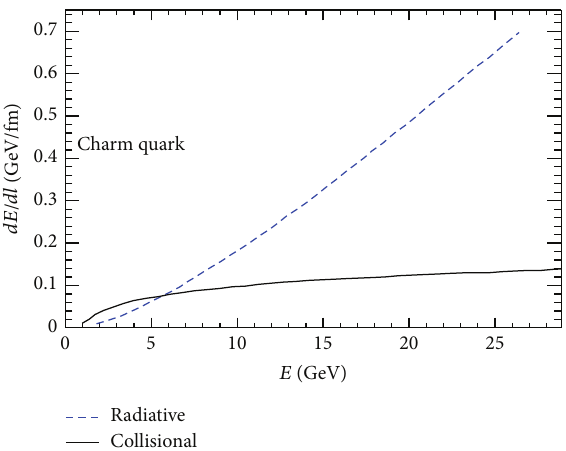
Figure 5: Radiative and collisional energy loss for charm quarks from [27] (model I) as a function of charm quark energy. Adopted from